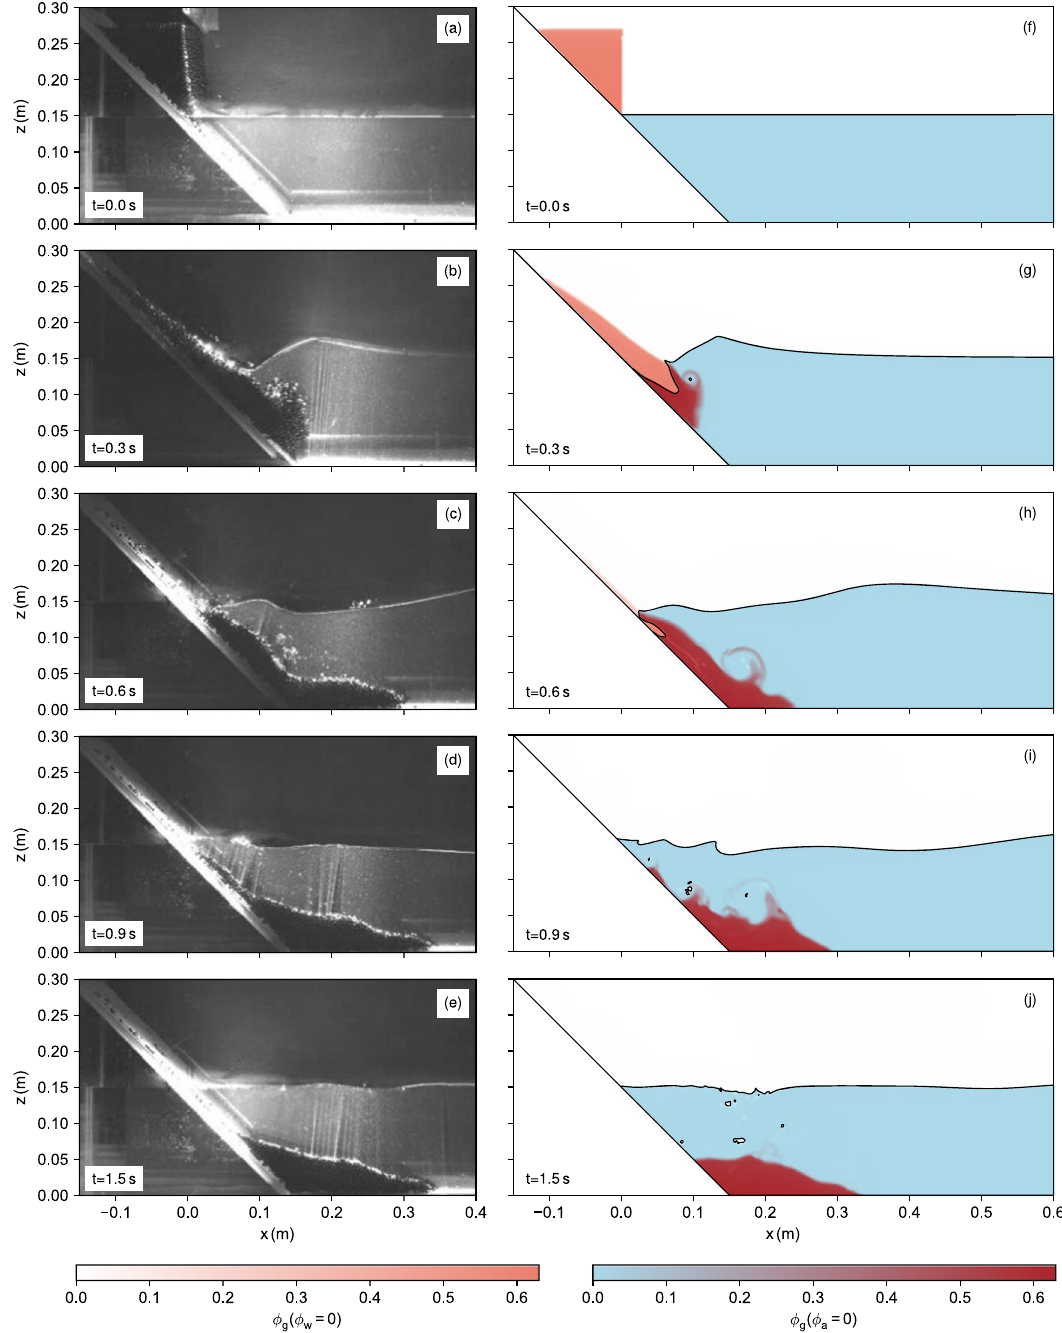
Fig. 3 Small-scale model results. Pictures of the experiments of Viroulet et al. 23 ( a – e ) and snapshots of the respective numerical simulation ( f – j ). The numerical results are visualised in terms of phase fractions. The interface between water and air is highlighted as a black line. The left colour map indicates the limiting case of dry regions, the right colour map the limiting state of water-saturated regions. Few regions are partially saturated due to the sharp interface between air and water. The full colour map is shown in Fig.